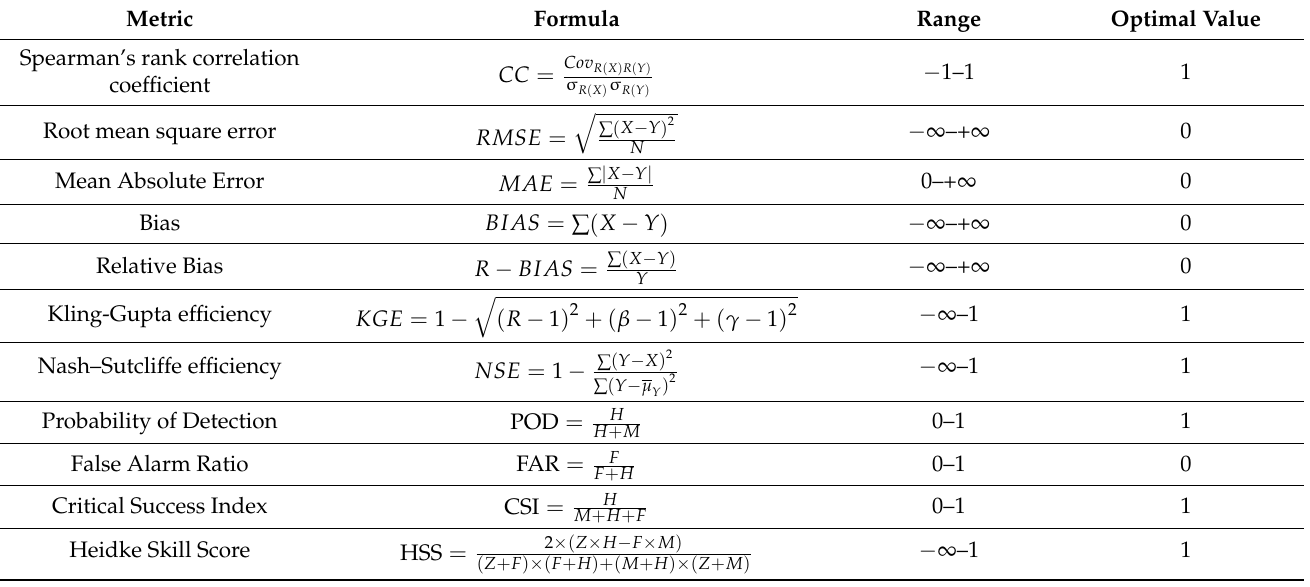
Table 2. Statistical metrics of continuous and categorical statistical scores used in this